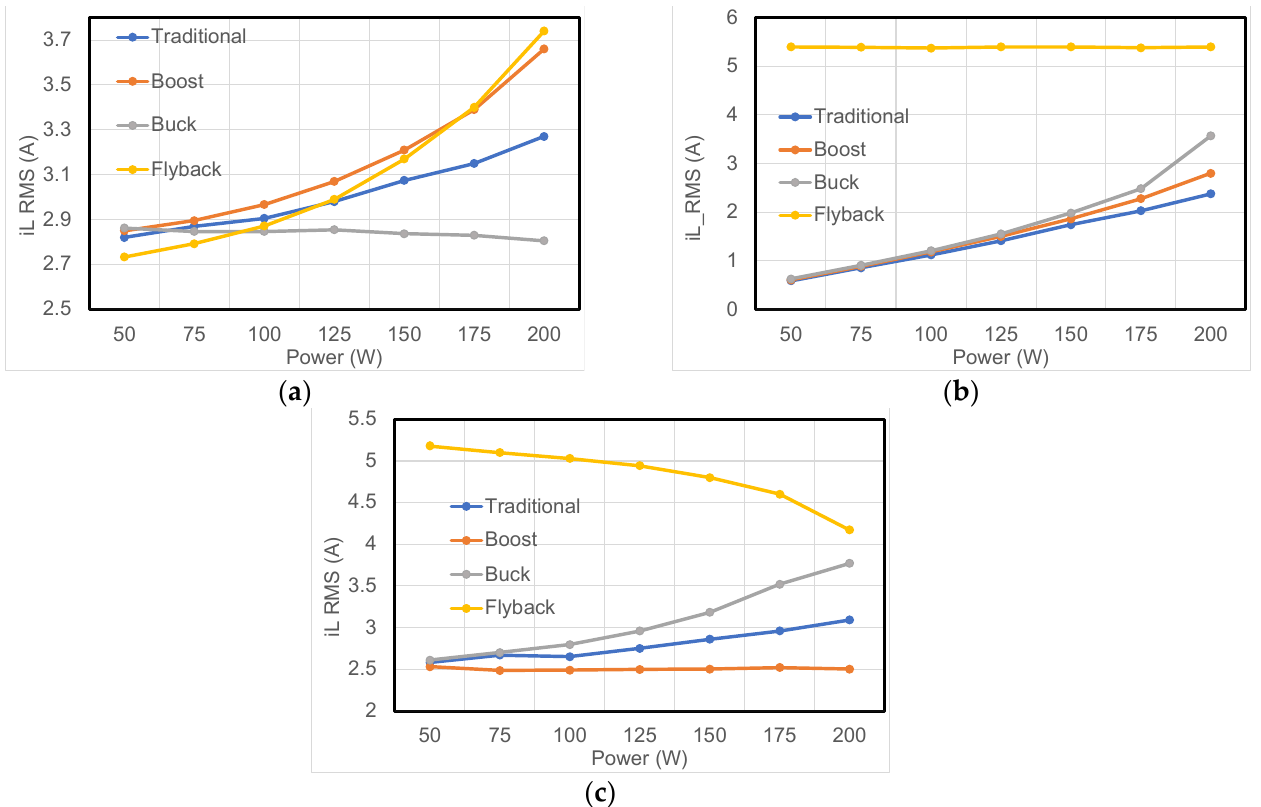
Figure 10. Series inductor RMS current for: ( a ) M = 0.5, ( b ) M = 1, ( c ) M = 2.